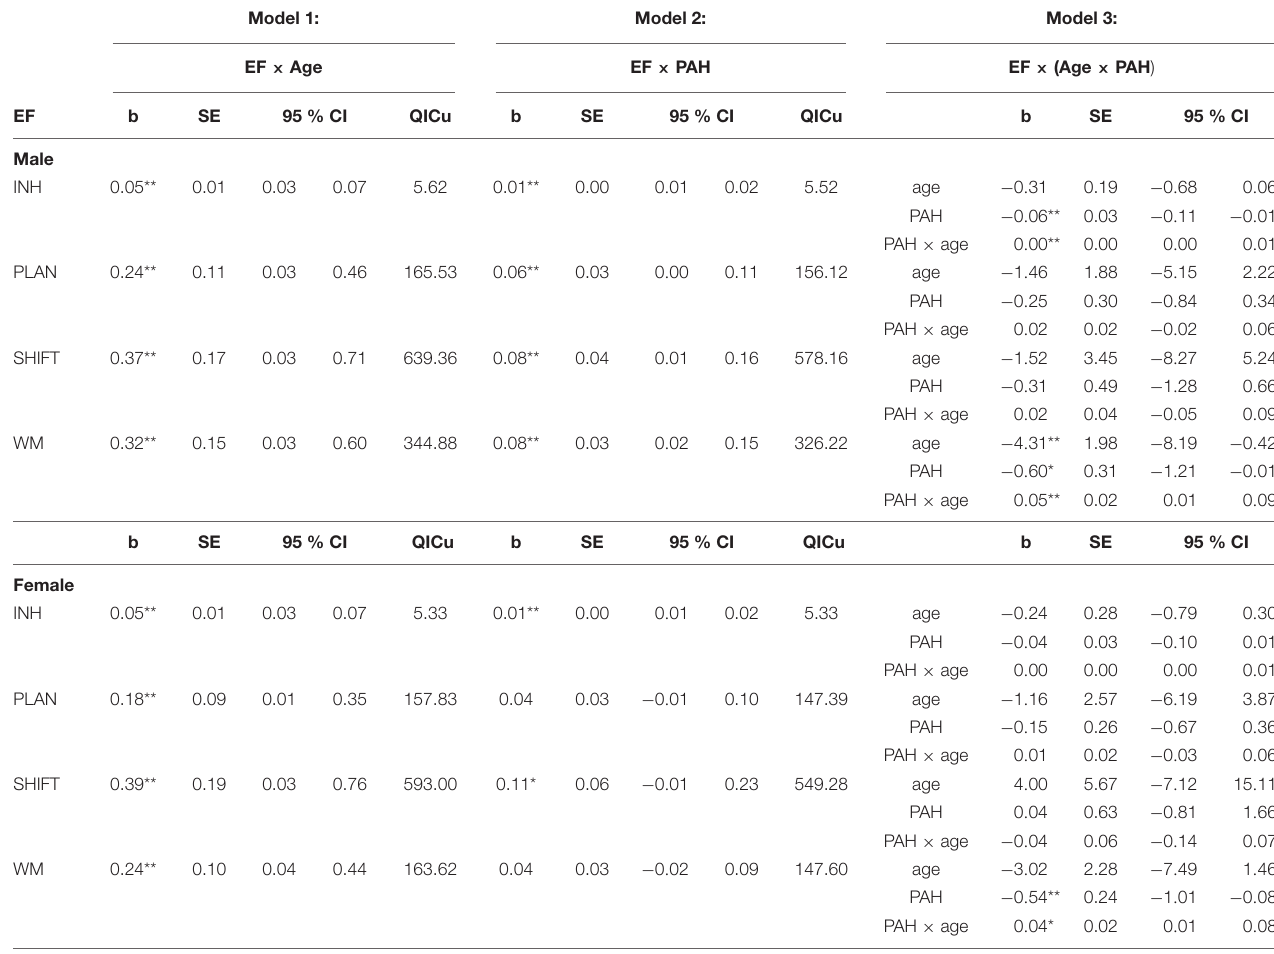
TABLE 3 | Outcomes of the three GEE models split out for males and females, for each EF component with the unstandardized coefficient (b), the standard error (SE) and the 95% Confidence Interval (95% CI). Model 1: Model 2: Model